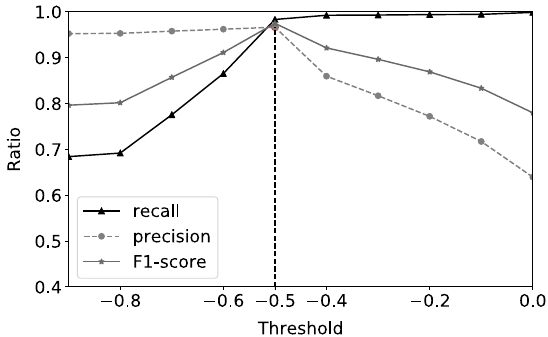
Fig. 6 The Performance of CS Discovery under different thresholds